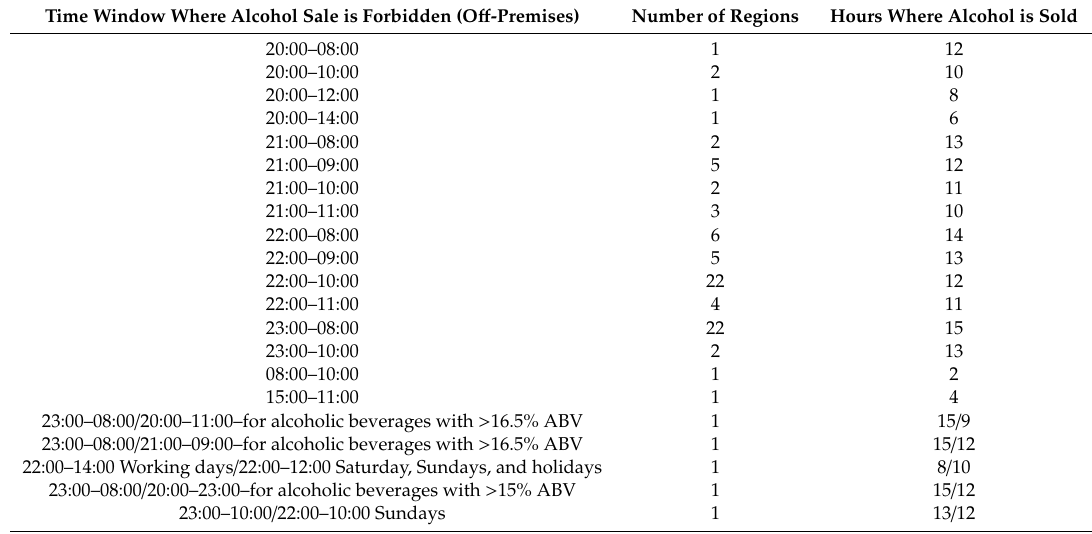
Table A7. Regional time restrictions on hours of alcohol sales (o ff -premise). Source: Consultant.ru. Time Window Where Alcohol Sale is Forbidden (O ff -Premises)